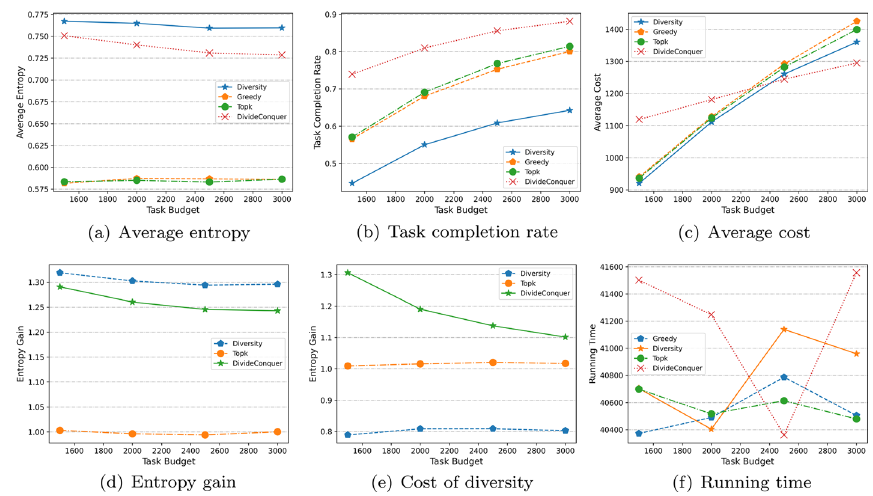
Fig. 4 Effect of the task